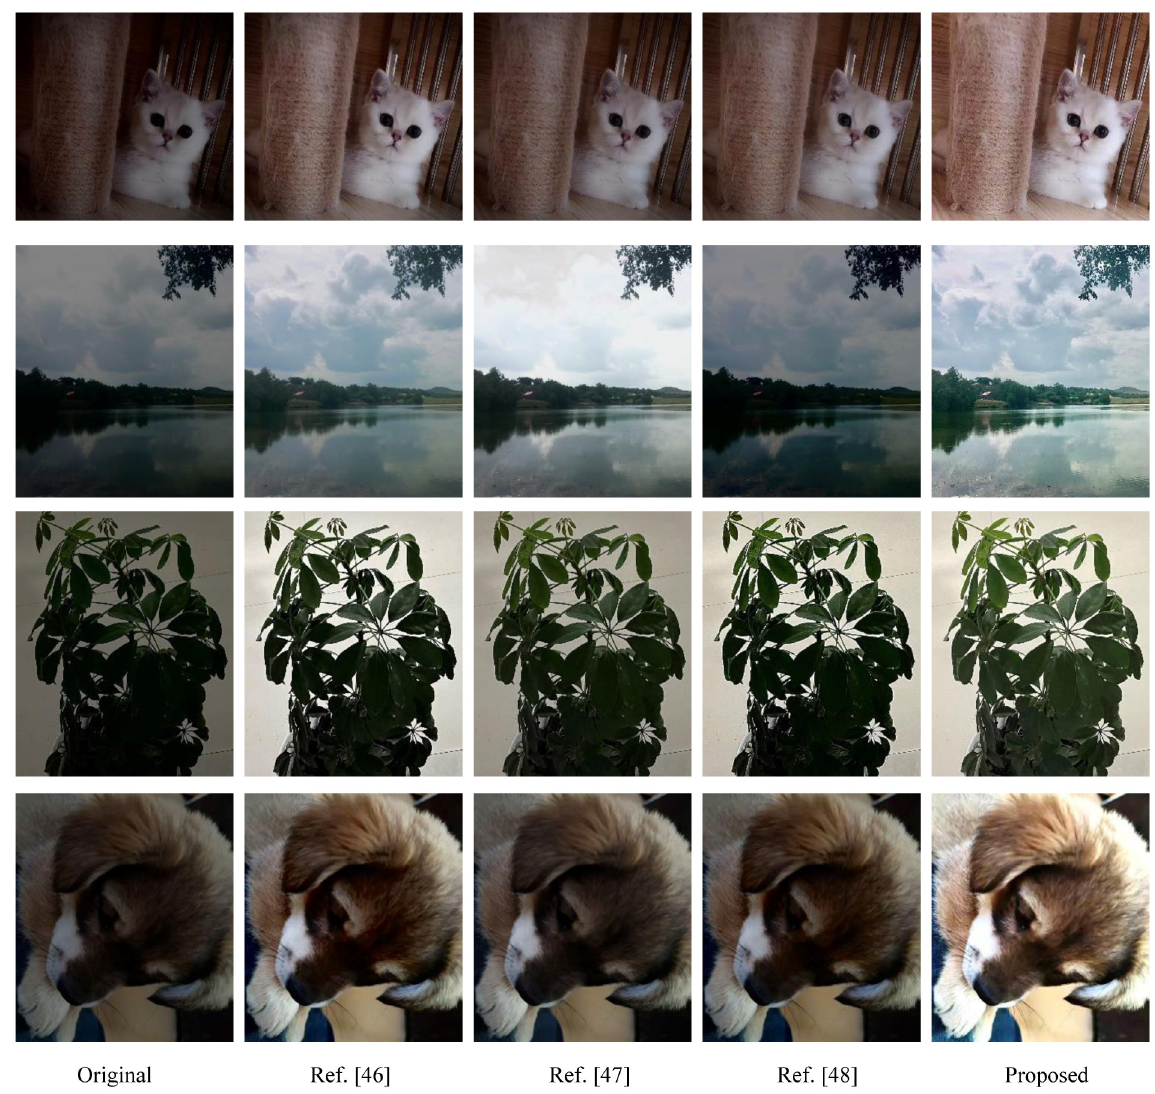
Fig 5. Visual quality performance comparison of the enhanced image obtained by various image enhancement approaches. The first column is the input images, the second to the fourth column2 are results of Ref. [45–47], respectively. The last column is the results of the proposed approach. From top to bottom, the test images are image 5–8.